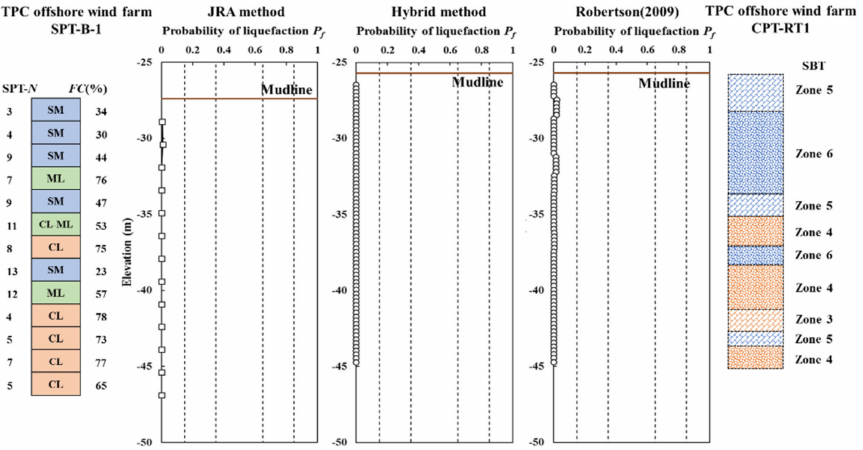
Figure 18. The probability of liquefaction of boreholes CPT-RT1 and SPT-B-1 in TPC offshore wind farm.